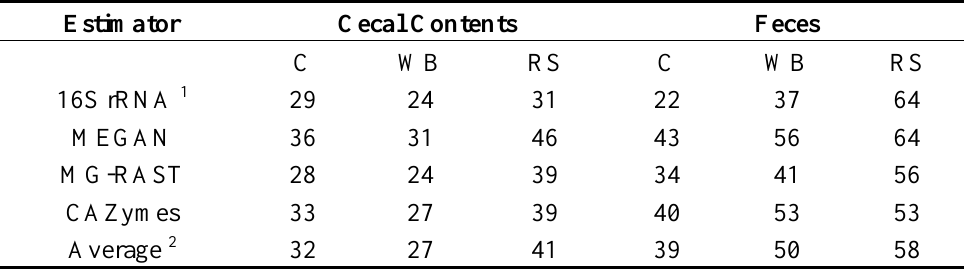
Figure 2. Multi-dimensional scaling (MDS) analysis using principle coordinates (PCoA) and cluster analysis of phylotype composition (presence/absence) and diversity (phylotype presence and abundance) in the cecal (Δ) and fecal (▲) communities of rats fed each diet. ( A ) MDS comparing phylotype content under each diet. p = 0.001, r 2 = 0.813; ( B ) Cluster analysis comparing phylotype content under each diet; ( C ) MDS comparing diversity under each diet. p = 0.001, r 2 = 0.960; ( D ) Cluster analysis comparing diversity under each diet. CC: cecal cellulose. FC: fecal cellulose. CWB: cecal wheat bran. FWB: fecal wheat bran. CRS: cecal resistant starch. FRS: fecal resistant starch. Table 3. Bacteroidetes content (% of total) in cecal contents and feces under each diet as determined by the assignment of 16S rRNA genes or by assignment of DNA sequences (MEGAN, MG-RAST) or contiguous (CAZymes) DNA sequences. Estimator Cecal Contents